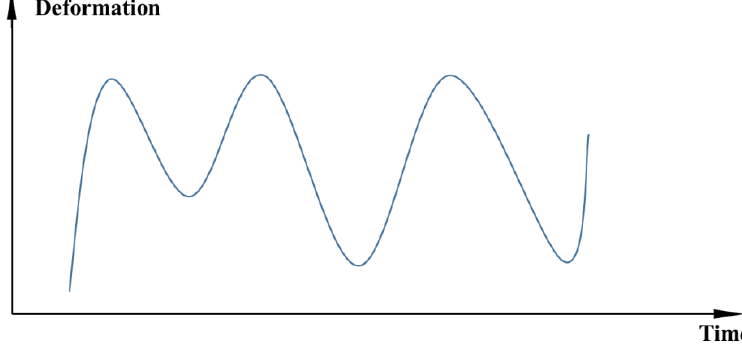
Figure 1. Time series data diagram. Table 1. Time series data structure.